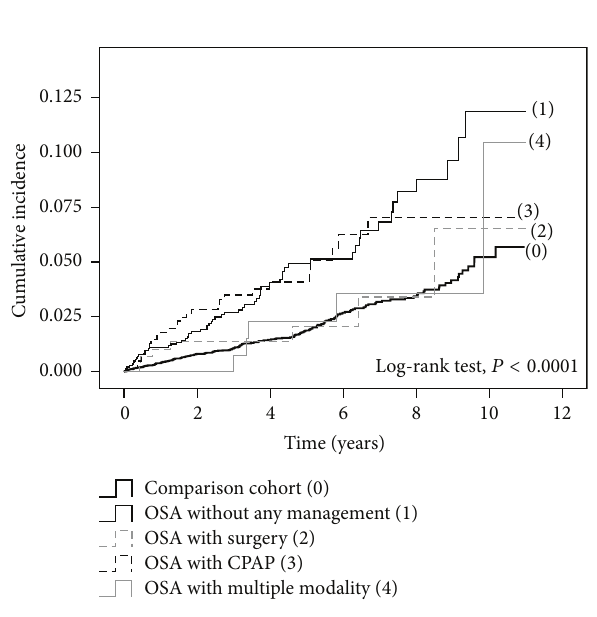
Figure 2: Cumulative incidence rates of glaucoma in study with/without